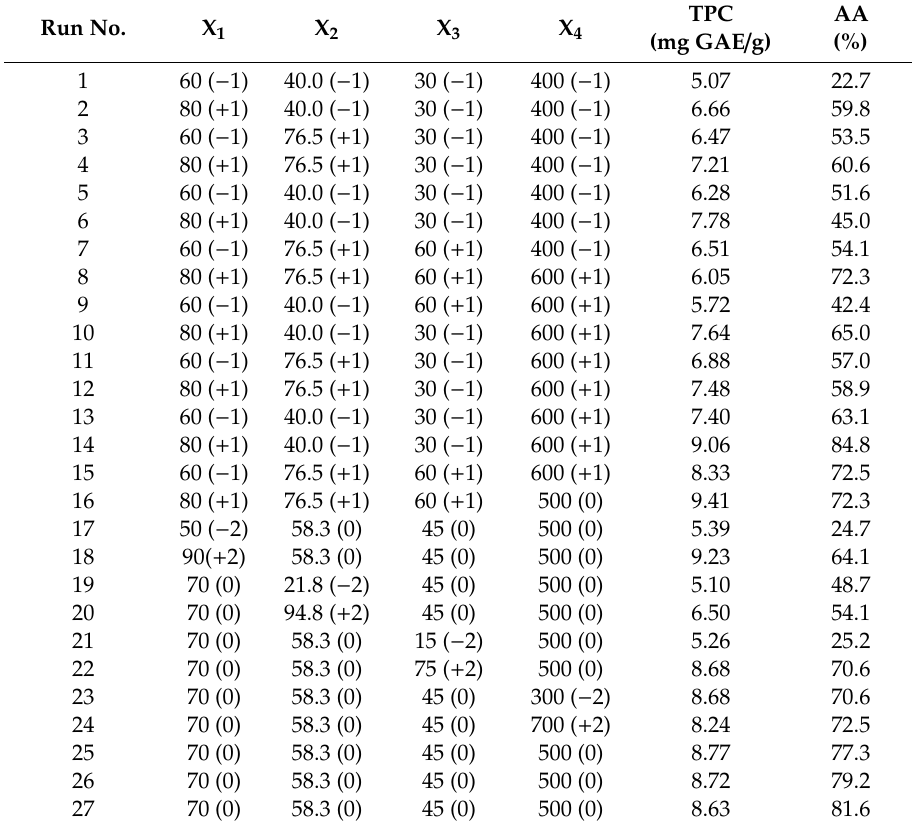
Table 2. Coded and experimental levels of the ultrasound-assisted extraction (UAE) operational parameters and experimental values for 27 experimental runs. Run No.